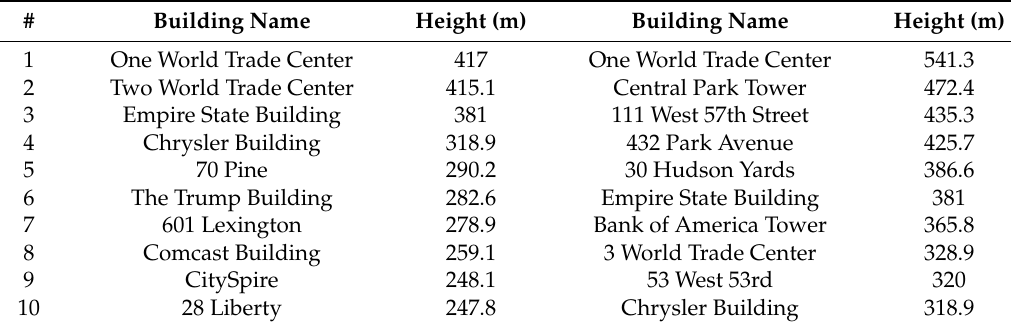
Figure 9. New York City in 2000 and 2020. Table 19. New York City’s 10 tallest skyscrapers in 2000 and 2020.